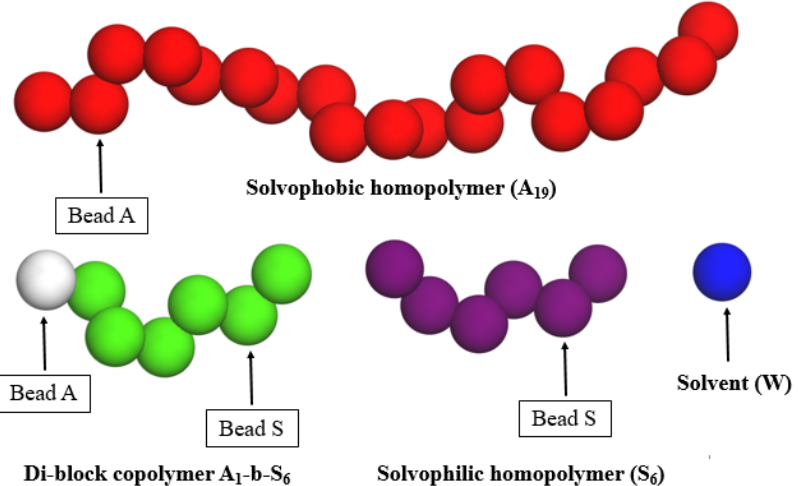
Figure 1. Schematic illustration of the solvophobic and solvophilic homopolymer, block copolymer, and solvent. Different color codes for beads A and S in the copolymer (white and green) and homopolymer (red and purple) chains are to clarify the chain locations in the assemblies in the simulations. Despite the color coding, beads A and S are chemically identical in both